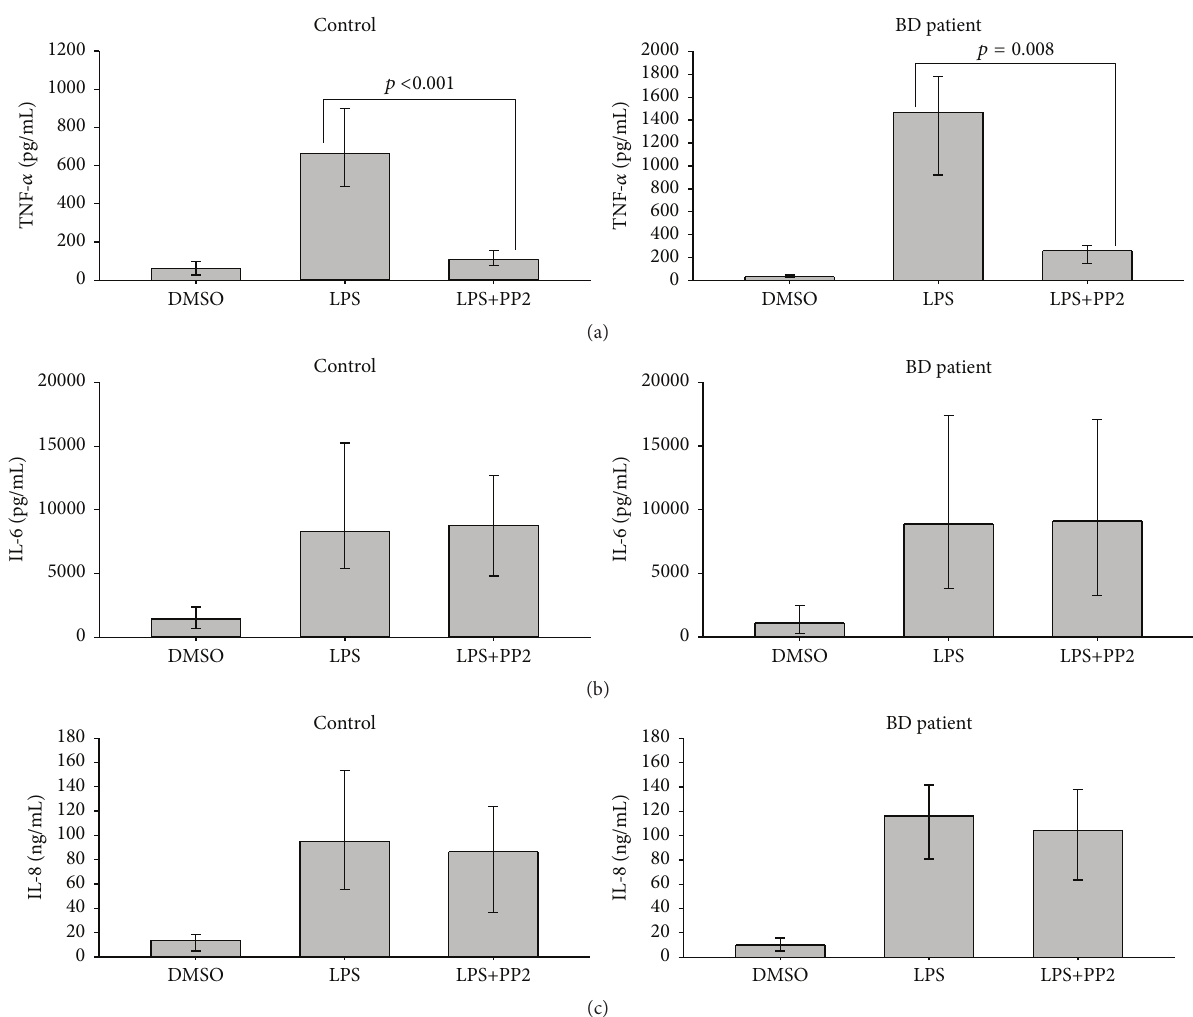
Figure 2: The effect of the PP2 on LPS-induced cytokine/chemokine production in PBMC. 0.5 × 10 6 PBMC were treated with 10 𝜇 M PP2 for 1h prior to stimulation with 100ng/mL LPS for 18h. Supernatants were collected and cytokine/chemokine levels determined by ELISA; TNF- 𝛼 (a), IL-6 (b), and IL-8 (c). The results are presented as pooled data from three independent experiments. The statistical significance of the data was analyzed by Student’s 𝑡 -test.